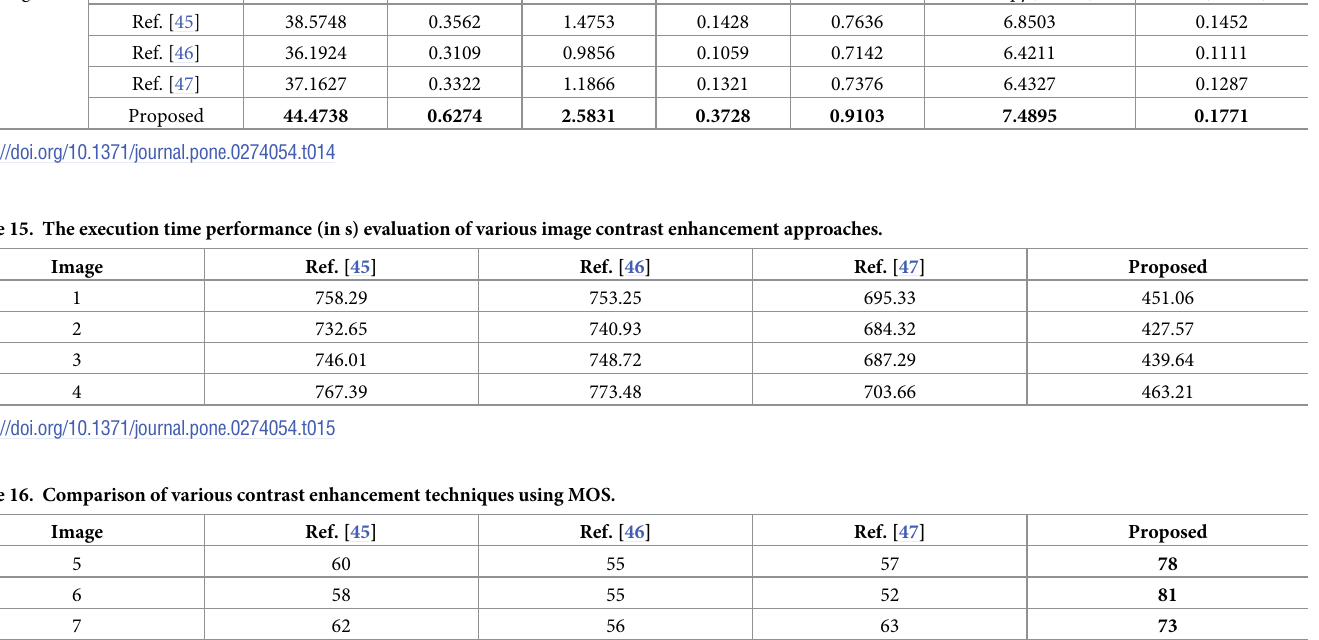
Table 14. The performance evaluation of various image contrast enhancement approaches using test images 8. Image8